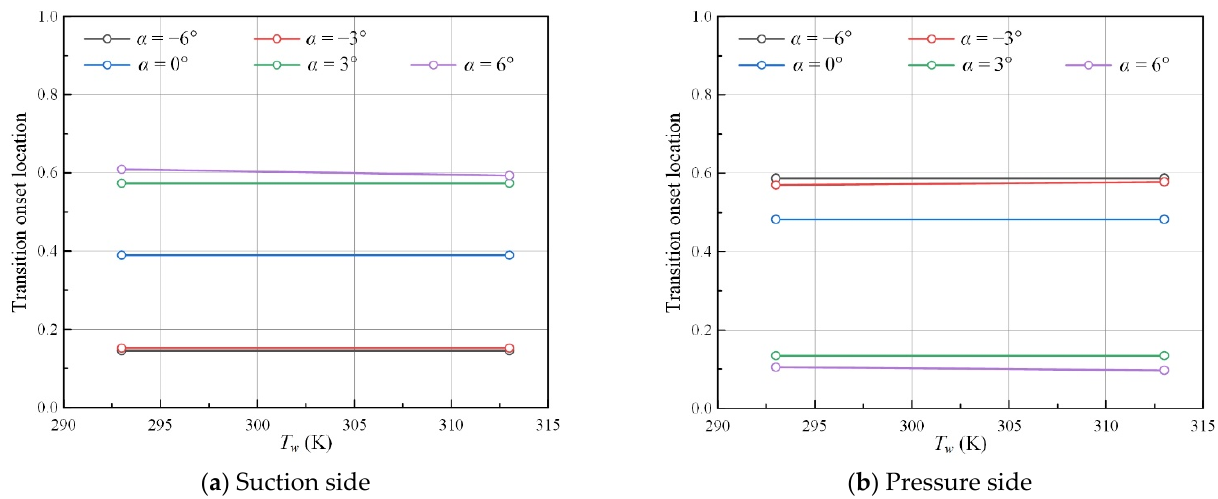
Figure 9. Transition onset locations under various surface temperatures ( ε = 0.5%, Ma = 0.6).